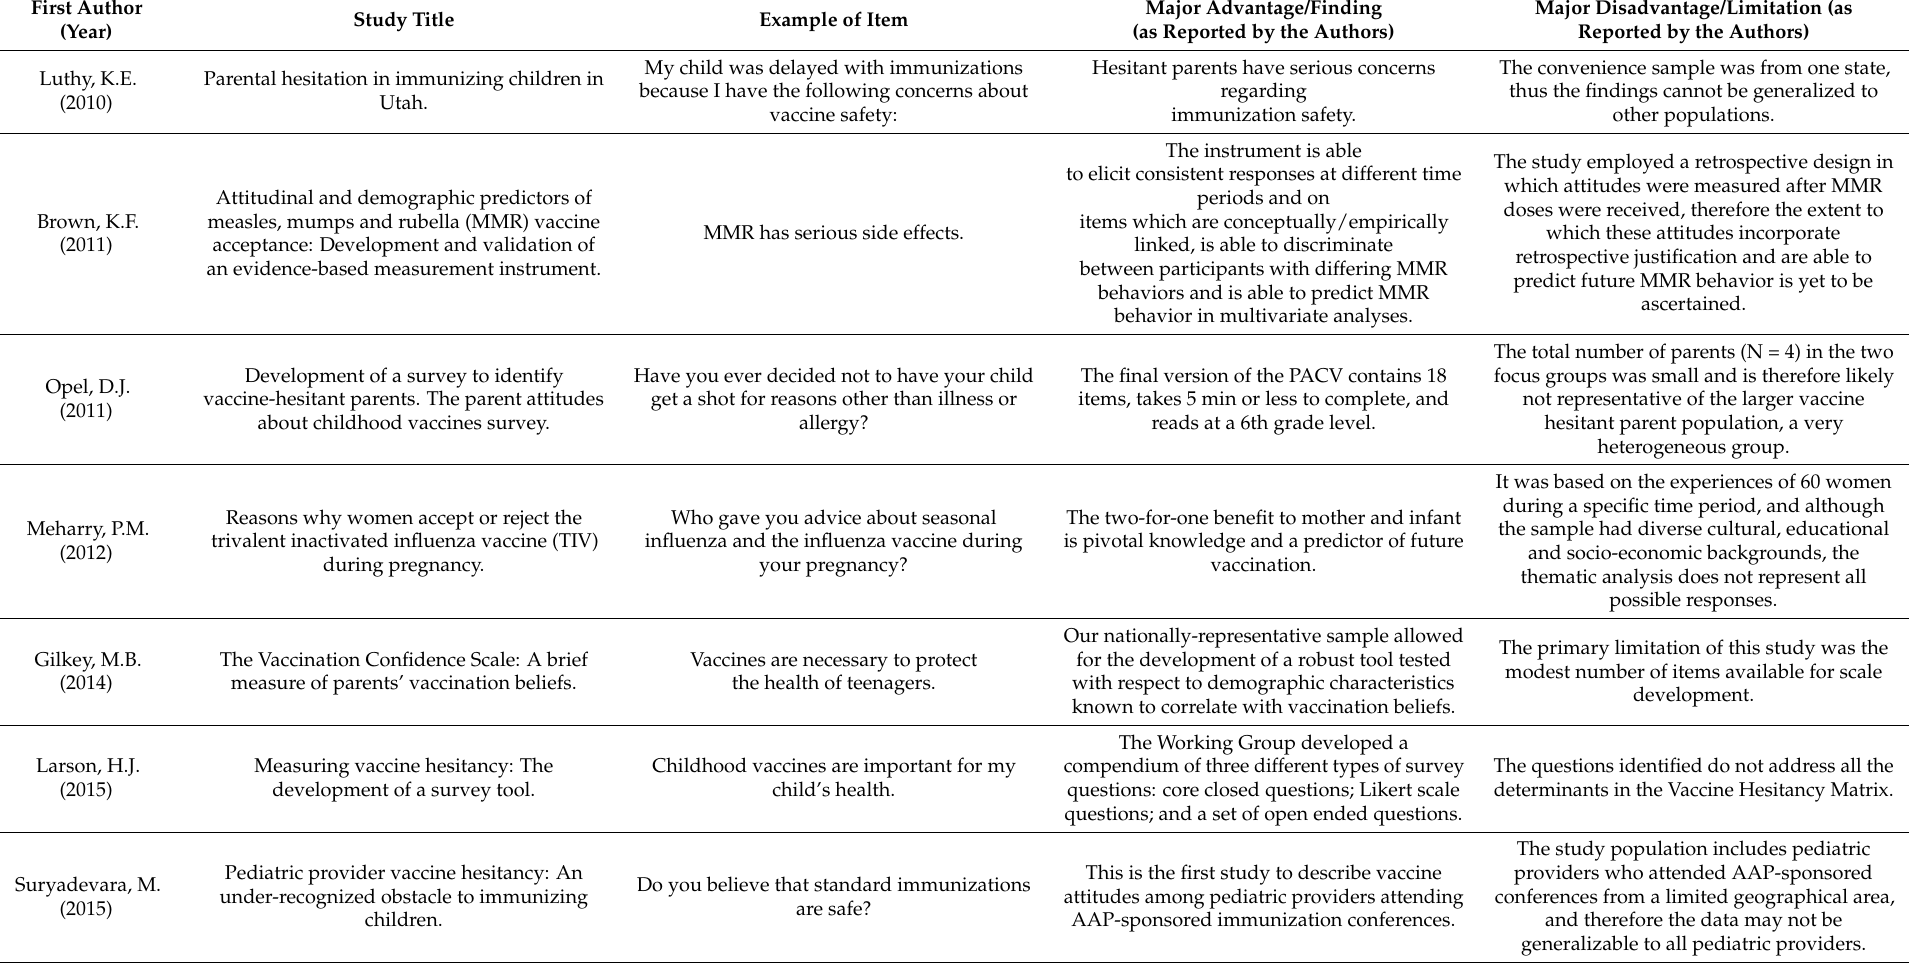
Table 1. Summary table with additional